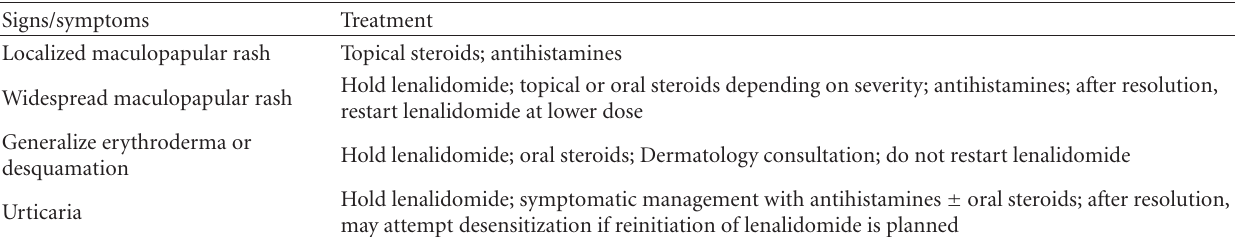
Table 7: Management of rashes due to